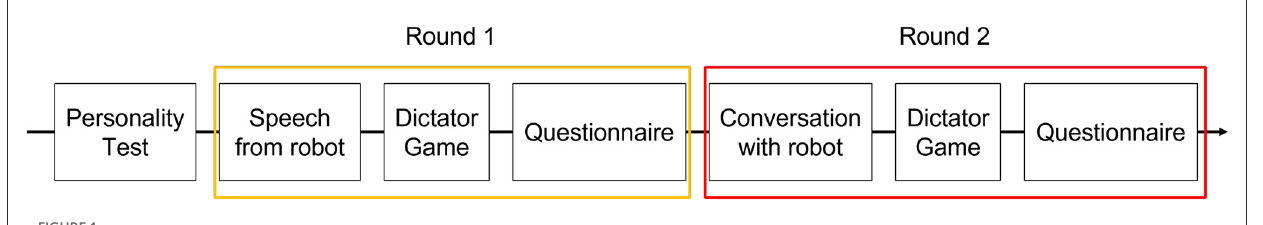
FIGURE1 Experimental flow.